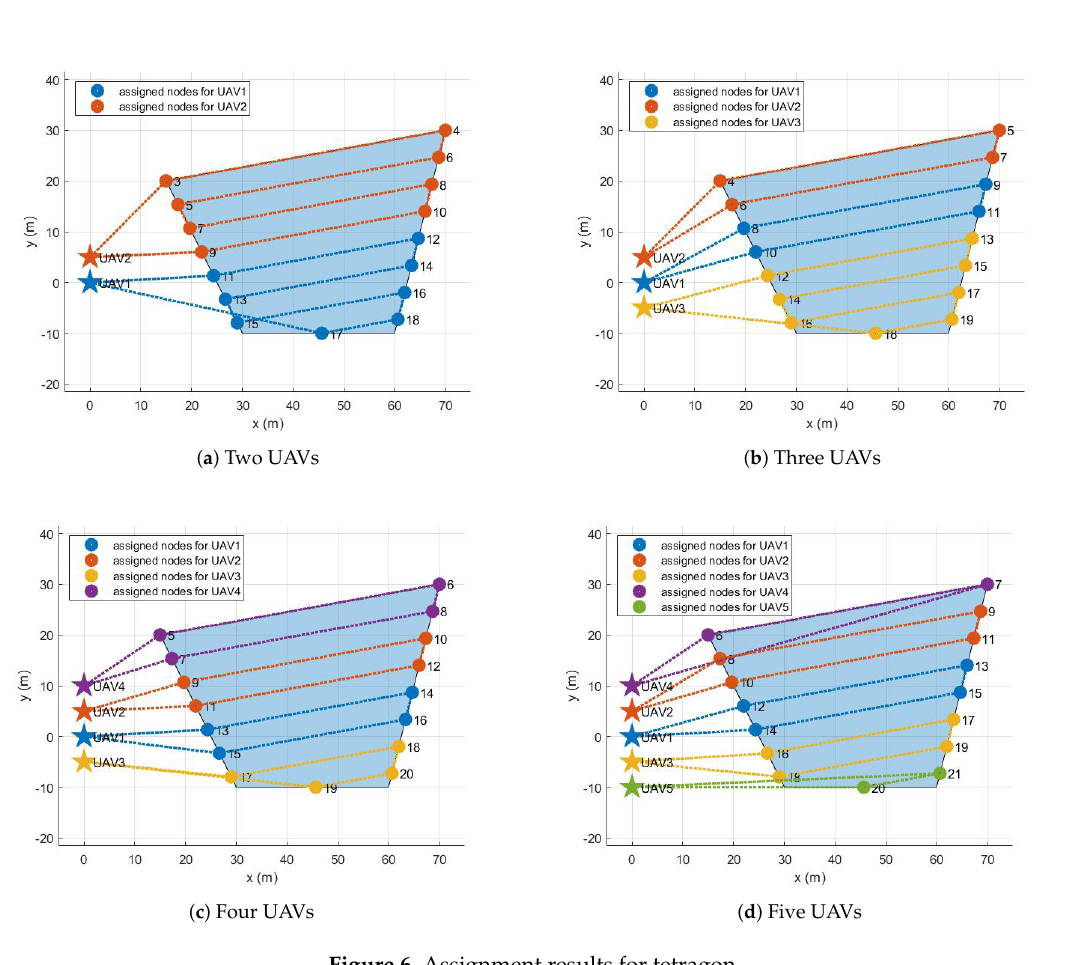
Figure 6. Assignment results for tetragon.